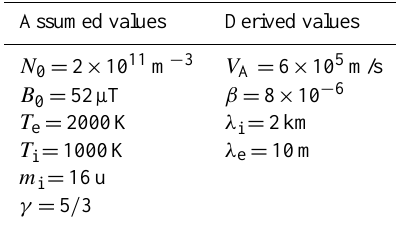
Table 1. Parameter values applicable for the ionospheric F